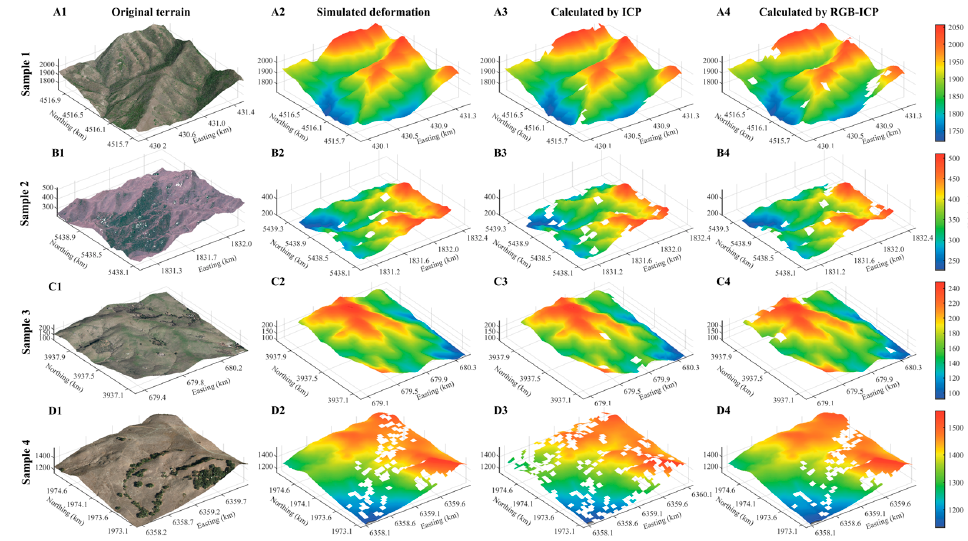
Figure 4. Three-dimensional maps of deformation-superimposed terrain obtained by applying the two algorithms (rough terrain): ( A1 – A4 ) original terrain; ( B1 – B4 ) simulated deformation superposition results; ( C1 – C4 ) deformation superposition results of ICP algorithm; ( D1 – D4 ) deformation superposition results of RGB-ICP algorithm.